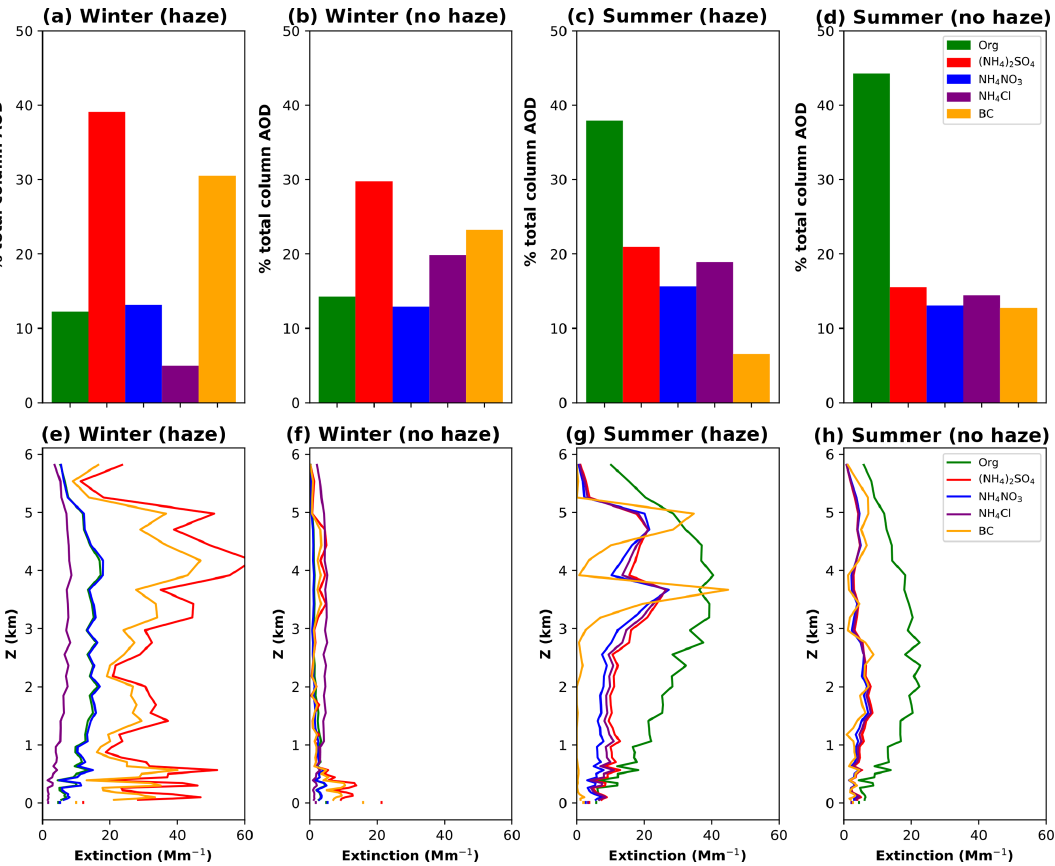
Figure 2. Contributions to total column AOD (a, b, c, d) and vertical profiles of extinction (e, f, g, h) for each aerosol component as derived from the optimization approach. Data are presented for haze and non-haze periods (see text for definition) in both campaigns from the surface up to 6km